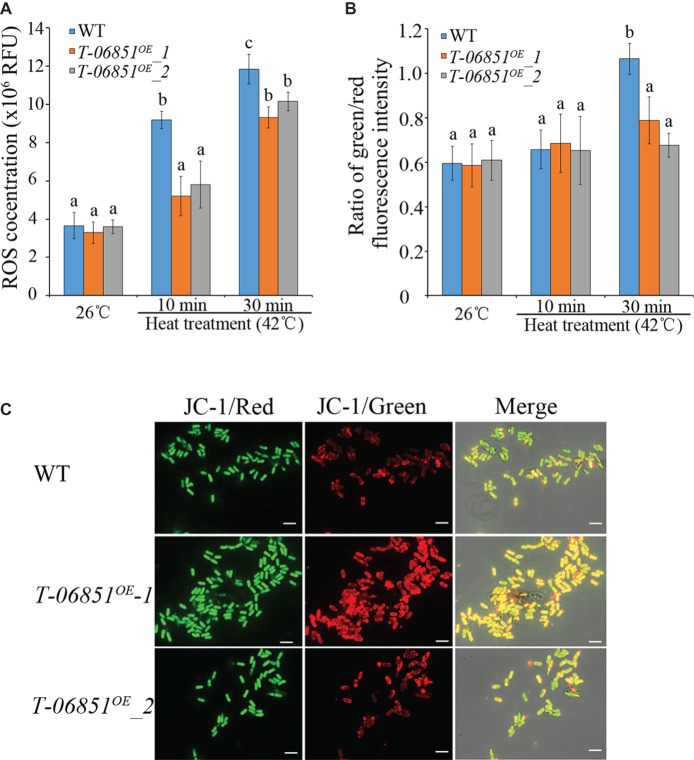
Increasing pyruvate concentration reduces the ROS level and prevents the collapse of mitochondrial membrane in conidia treated with heat (42°C, a widely used temperature for assaying heat stress tolerance of M. robertsii conidia). (A) ROS levels in the conidia at the optimal temperature (26°C) and the heat-treated conidia. RFU: relative fluorescence units. (B) Pyruvate prevents the collapse of mitochondrial membrane potential. The green/red fluorescence intensity ratio represents the extent to which the mitochondrial membrane potential collapses. (C) Typical pictures representative of five repeats of JC-1 staining for analysis of the mitochondrial membrane potential collapses. Bars, 10 μm. Values with different letters are significantly different (Tukey’s test in one-way ANOVA, p < 0.05). WT: The wild-type strain; T-06851OE-1 and T-06851OE-2: two independent transformants with elevated pyruvate concentrations in the conidia.